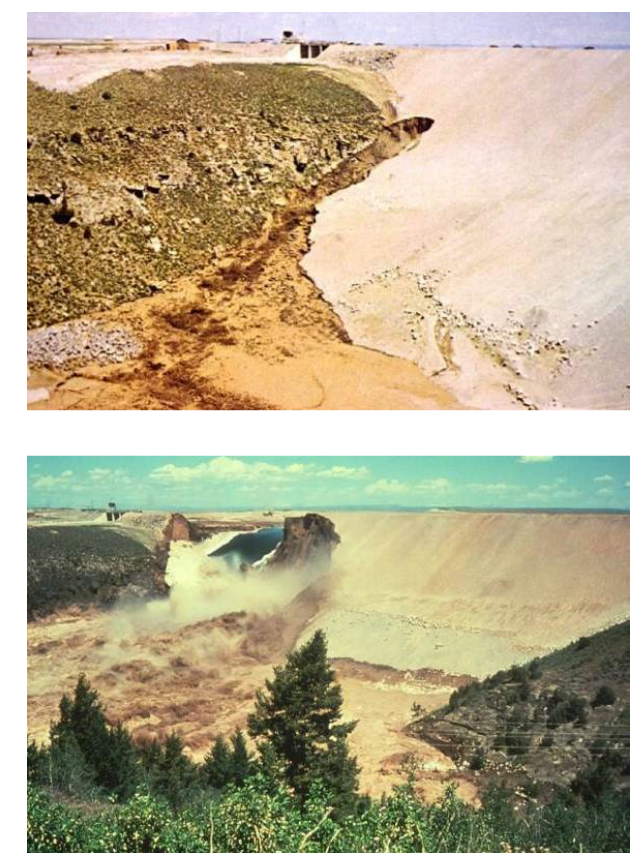
Figure 10. Images of the rupture of the Teton Dam, on the river of the same name, on 5 June 1976, Rexburg,